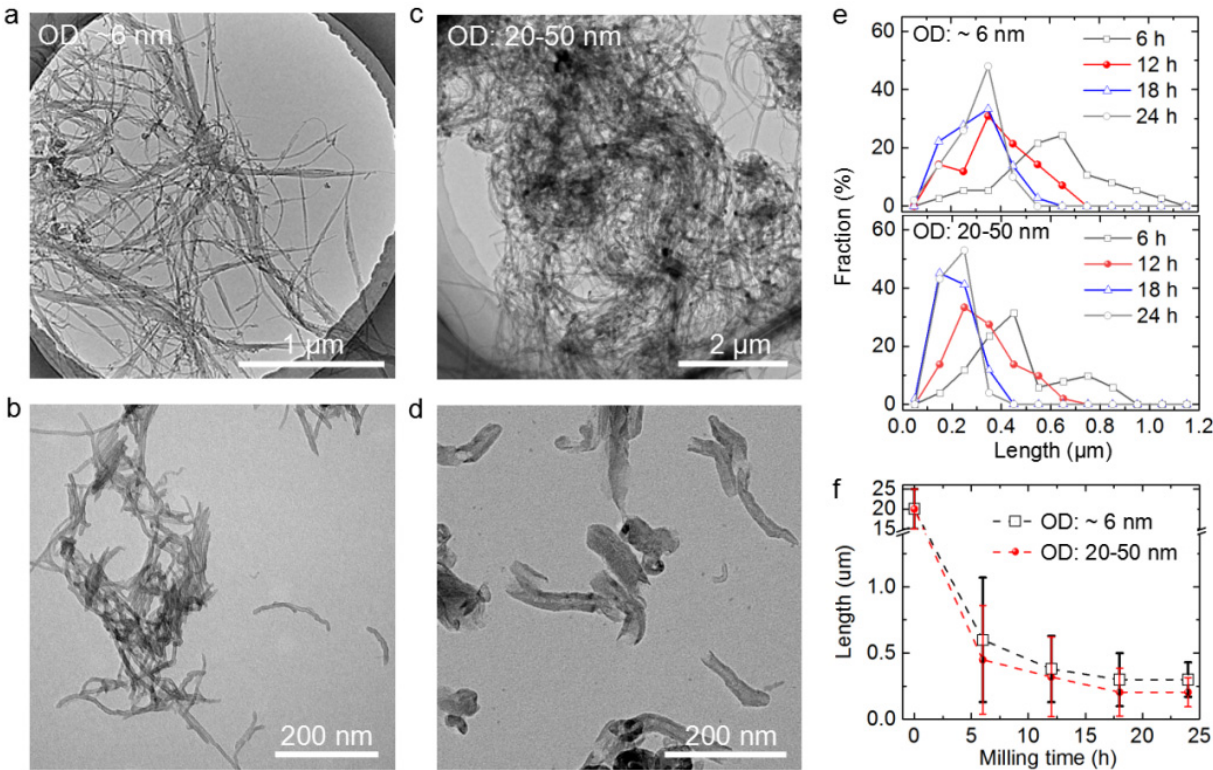
Figure 2. Ball milling treatment results of two kinds of CNTs. Transmission electron microscopy (TEM) images of the 6 nm-wide multi-walled carbon nanotubes (MWCNTs) before ( a ) and after ( b ) 24 h ball milling treatment and acid pickling. Figures ( c ) and ( d ) display the TEM images of 20–50 nm-wide MWCNTs before and after 24 h ball milling treatment and acid pickling, respectively. The upper and lower images in ( e ) display the length statistical analysis results of the 6 nm-wide MWCNTs and the 20–50 nm-wide MWCNTs, respectively. ( f ) Average lengths of both kinds of MWCNTs plotted against ball milling time.